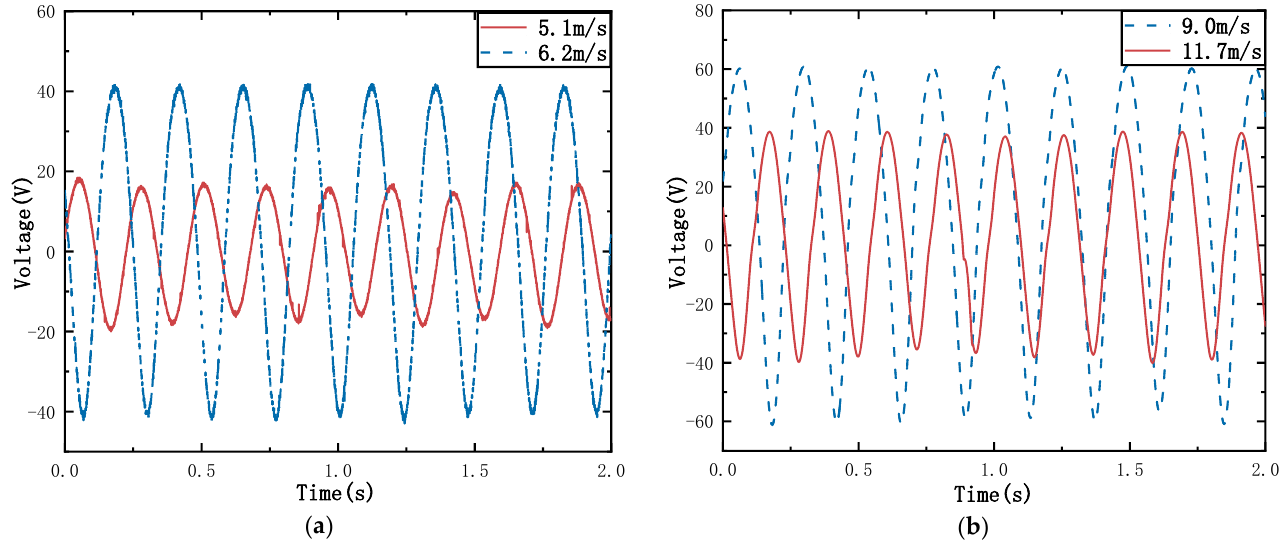
Figure 11. Time story of output voltage for VFPEH-30 at different wind velocities: ( a ) 5.1m/s and 6.2m/s; ( b ) 9.0m/s and 11.7 m/s.